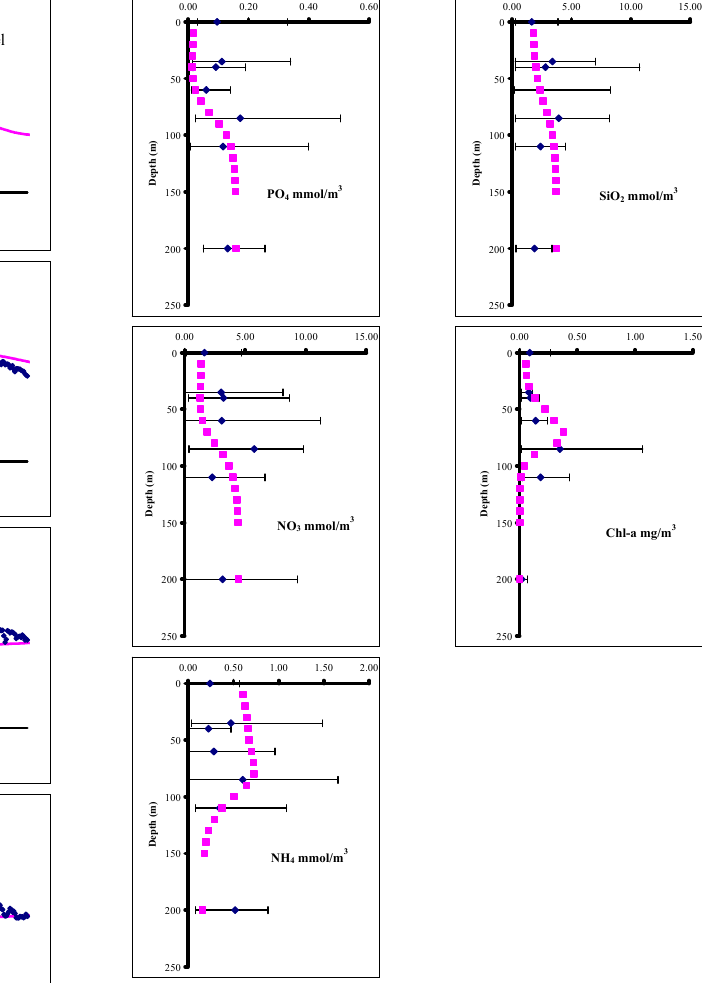
Fig. 4. Validation of model Phosphate, Nitrate, Ammonia, Silicate and Chl-a with in situ data obtained during maintenance trips. All sampling measurements at a particular depth are treated as repli- cates and averaged. Range bars are used to indicate variability (min- imum and maximum